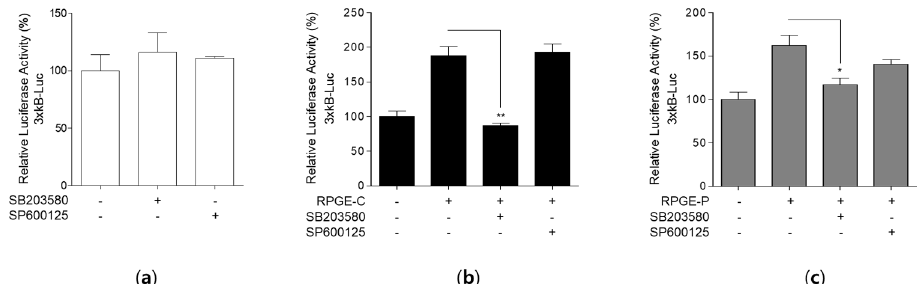
Figure 7. Effect of MAPK signaling on NF- κ B activation in RAW 264.7 cells. ( a ) without RPGEs; ( b ) RPGE-C; ( c ) RPGE-P. Luciferase activity was expressed as a relative value to that of the VC (-), which is set to 100%. The figures show the mean ± SEM. *p < 0.05 and **p < 0.01 when compared with cells treated with RPGEs alone. SB203580, p38 MAPK inhibitor and SP600125, JNK inhibitor.